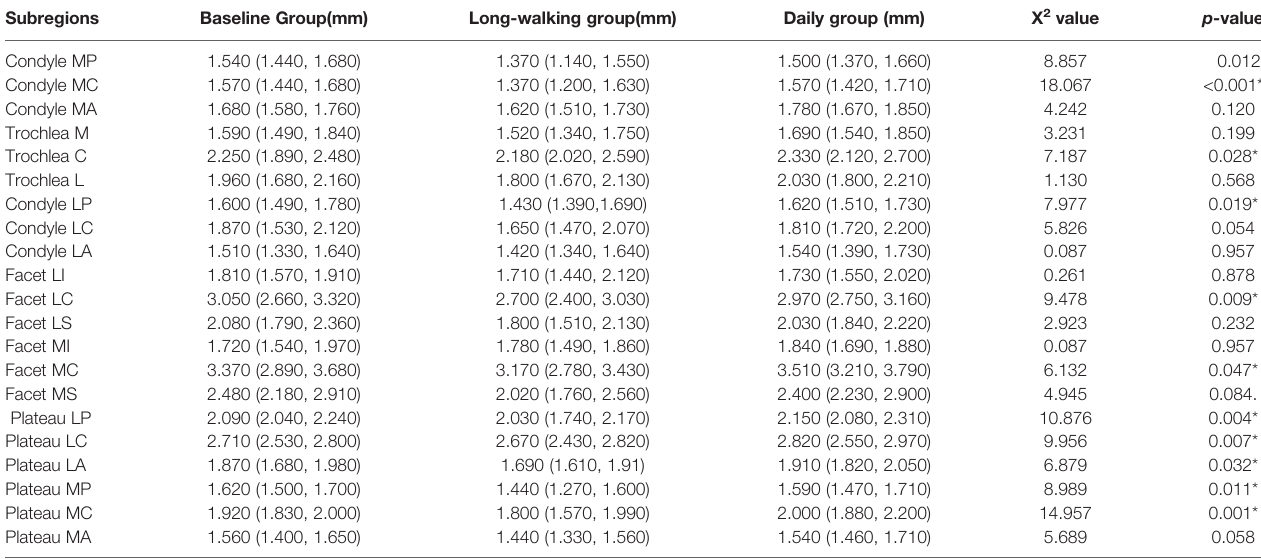
The values are expressed as median (P25, P75) and compared using X 2 and corresponding p values (n = 23). * Indicates statistical signi fi cance.